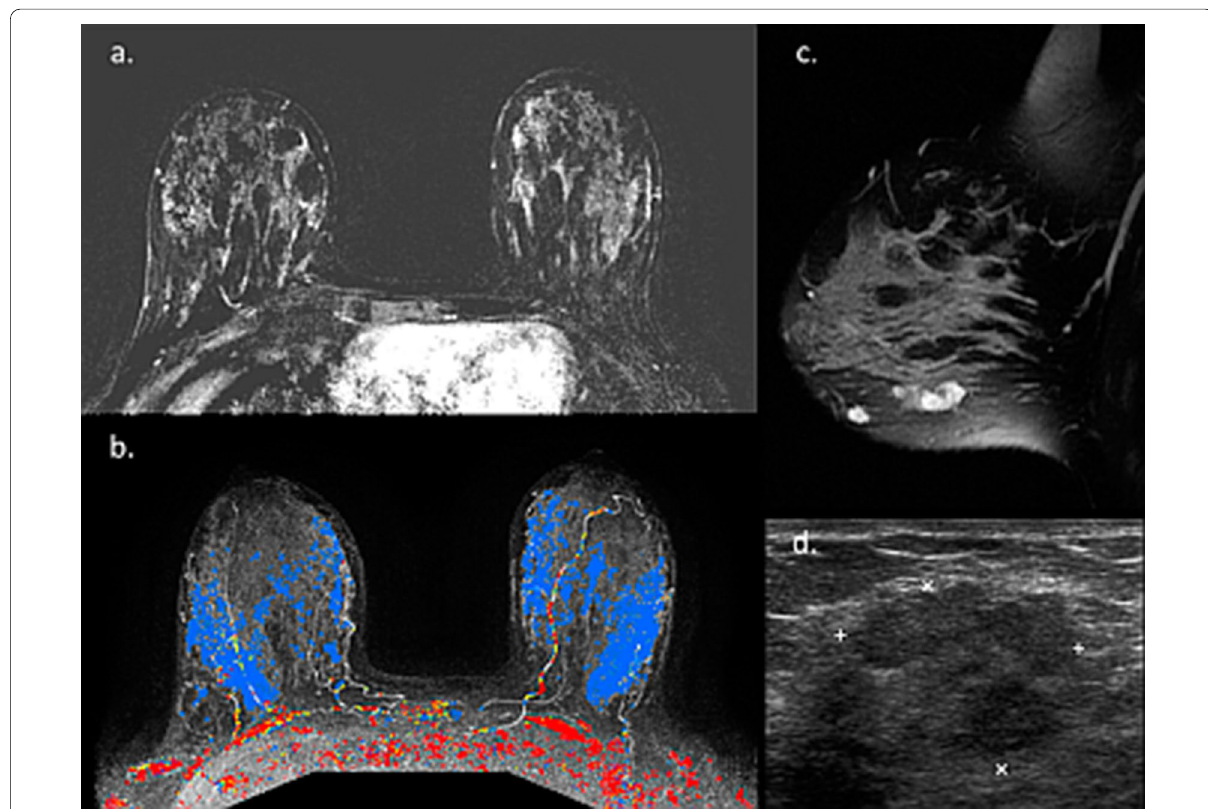
Fig. 12 MRI of mucinous carcinoma during pregnancy. MR images of patient with left sided mucinous carcinoma, presented as a palpable mass during pregnancy are presented. The patient chose to undergo elected abortion. Subtraction DCE image reveals marked bilateral BPE ( a ) and CAD reveal bilateral diffuse benign‑like coloring with progressive enhancement in time intensity curves ( b ) without evidence of the known underlying lesions in the left breast. However, the lesions, diagnosed on US ( d ), were clearly visible on sagittal T2‑weighted fat‑suppressed image ( c